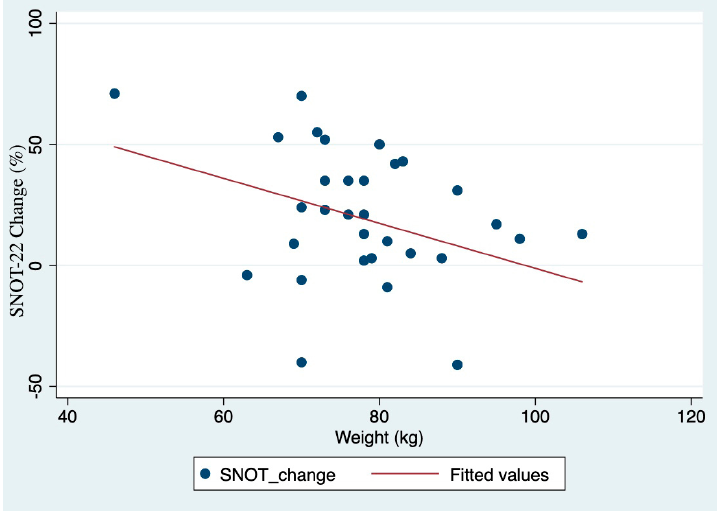
Figure 2. Correlation between the change in SNOT − 22 questionnaire and body weight. Table 2. Predictors of clinical response.